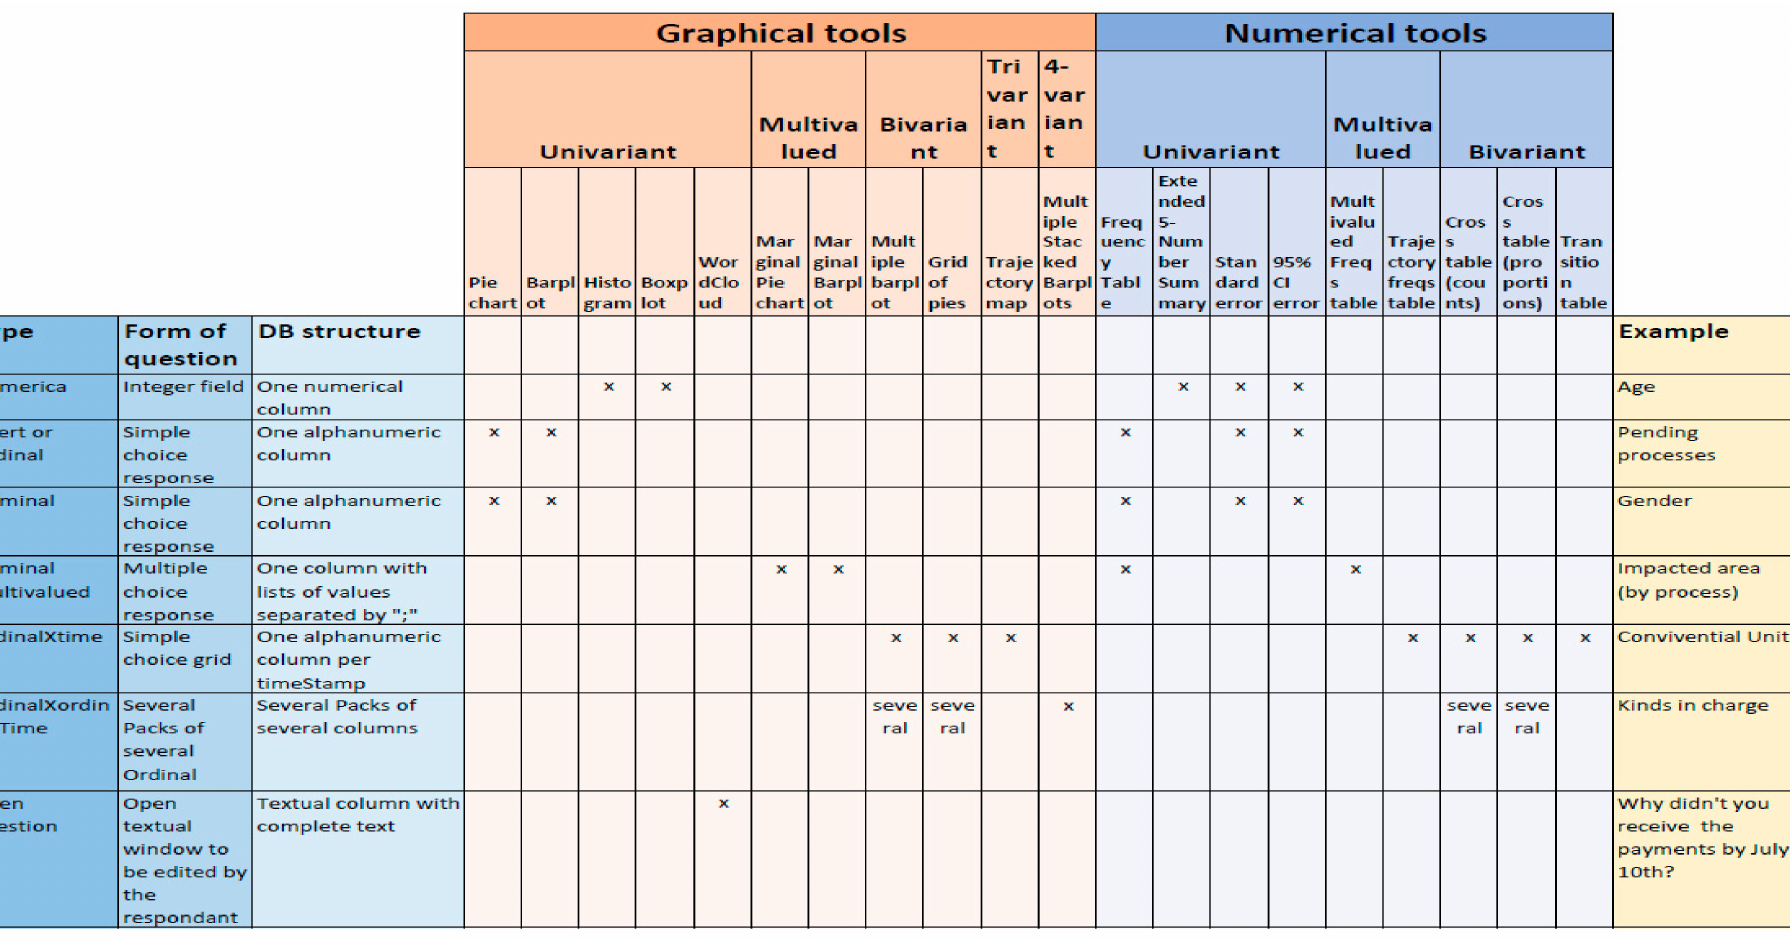
Figure 7. Typology of questions, variables, data structures and analysis